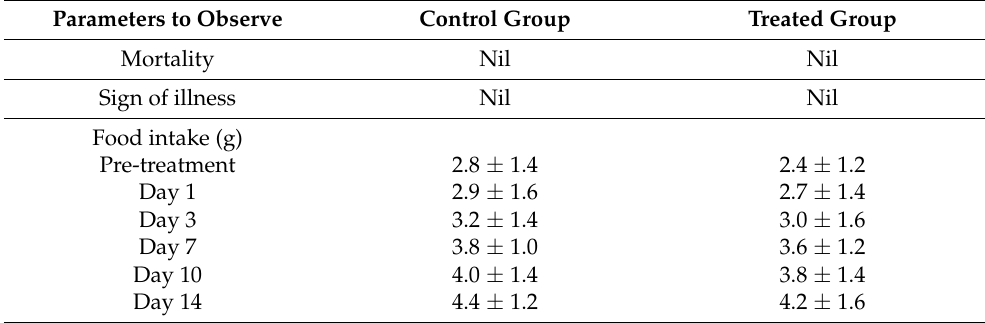
Table 6. Observations (Mortality, illness sign, food intake, water intake, and body weight) in control and TRHC-PAG-alginate microspheres treated group.